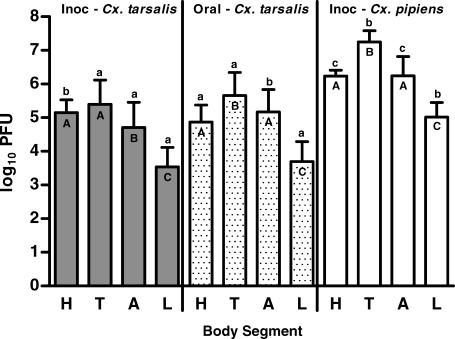

Culex Mosquitoes Contain High Amounts of WNVGeometric mean WNV titers in head (H), thorax (T), abdomen (A), and legs (L) of orally (Oral) or parenterally (Inoc) infected Cx. tarsalis and parenterally infected Cx. pipiens. Orally infected mosquitoes were tested at day 16 PI and parenterally infected mosquitoes were tested at day 7 PI. Letters within bars designate body segment titers that are significantly different from one another (p < 0.05) within each mosquito group. Letters above bars designate the mosquito groups that differ significantly from one another (p < 0.05) when compared by body segment. Error bars show standard deviation. LOD of plaque assay was 5 PFU.